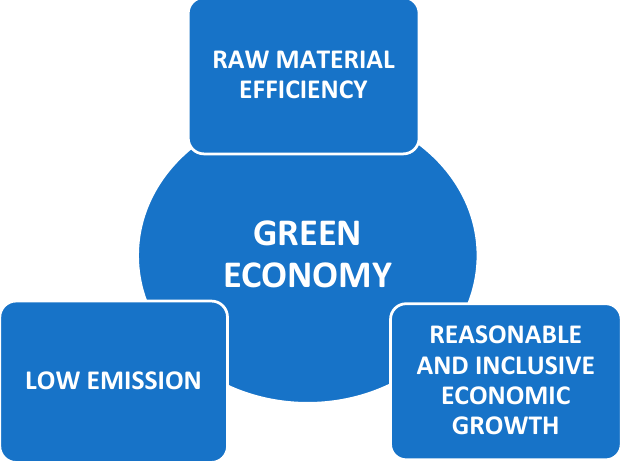
Figure 1. Features of a green economy. Source: own elaboration.